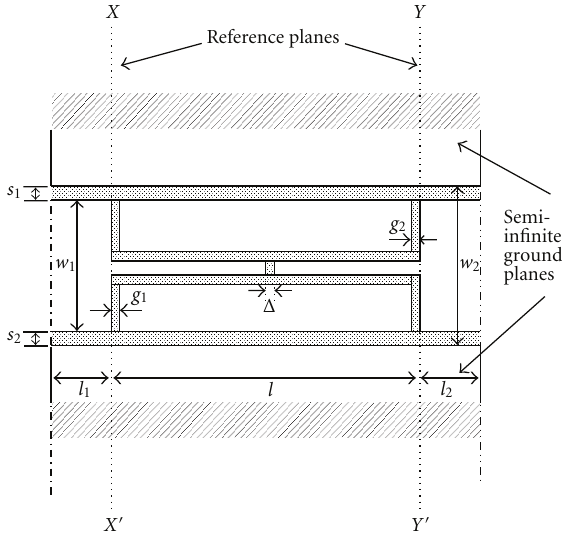
Figure 2: The layout of the discontinuity structure unit-cell (DS-